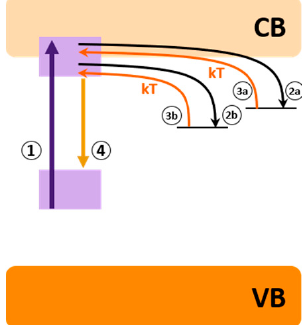
Figure 6. PeL simplified mechanism. VB is the valence band, CB conducting band, and kT is thermal energy.